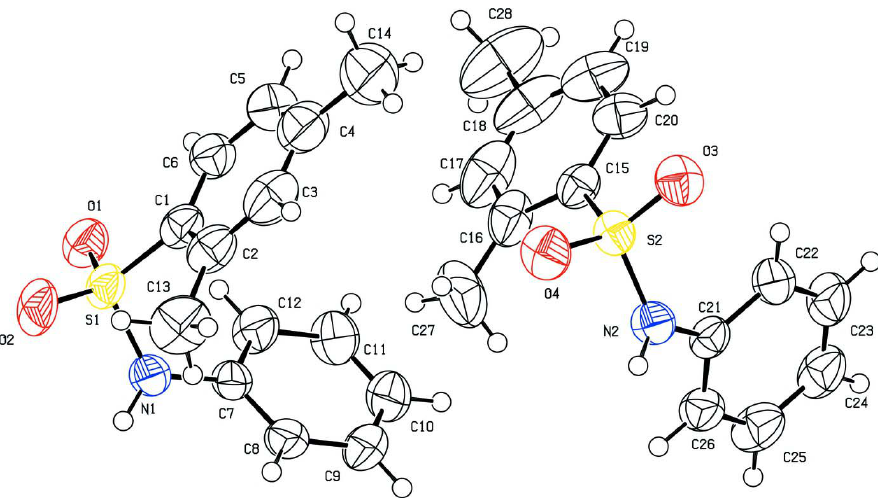
Figure 1 Molecular structure of the title compound, showing the atom labeling scheme. The displacement ellipsoids are drawn at the 50% probability level. The H atoms are represented as small spheres of arbitrary radii.